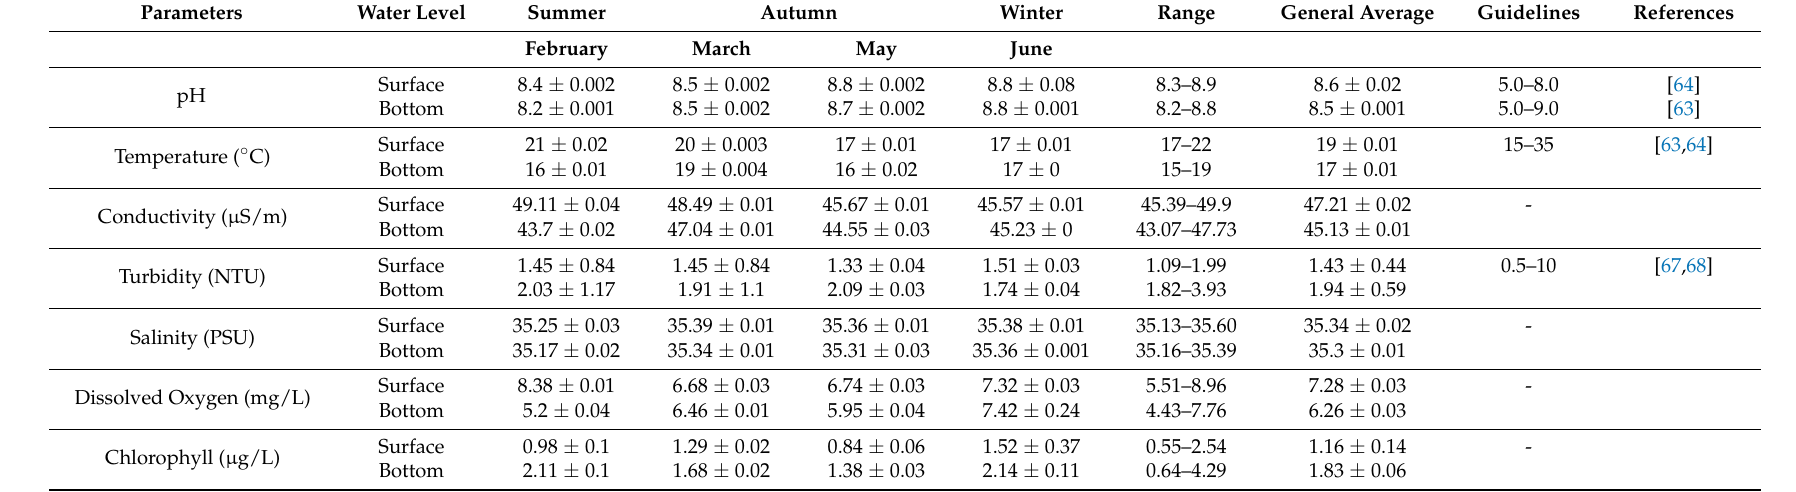
Table 3. Seasonal and overall average values for the physicochemical parameters in the water